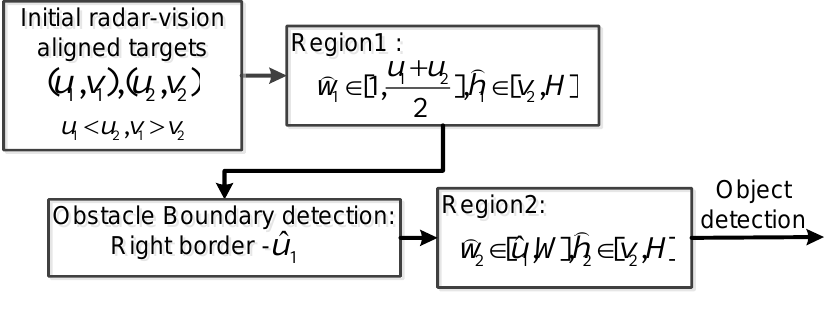
Figure 7. Region searching strategy for two potential